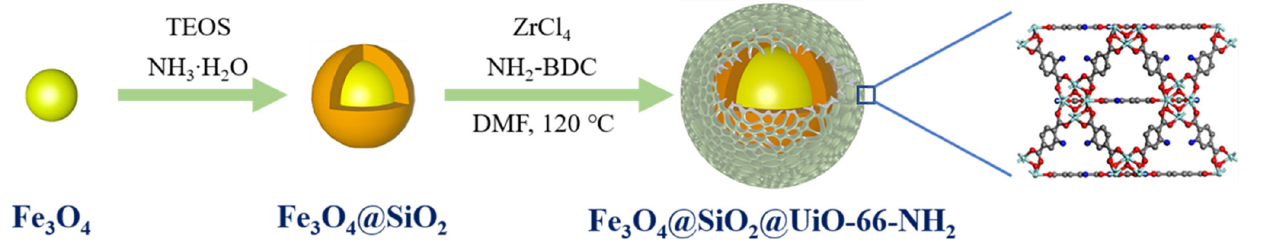
Figure 14. Synthesis of core-shell magnetic MOF composites [118].